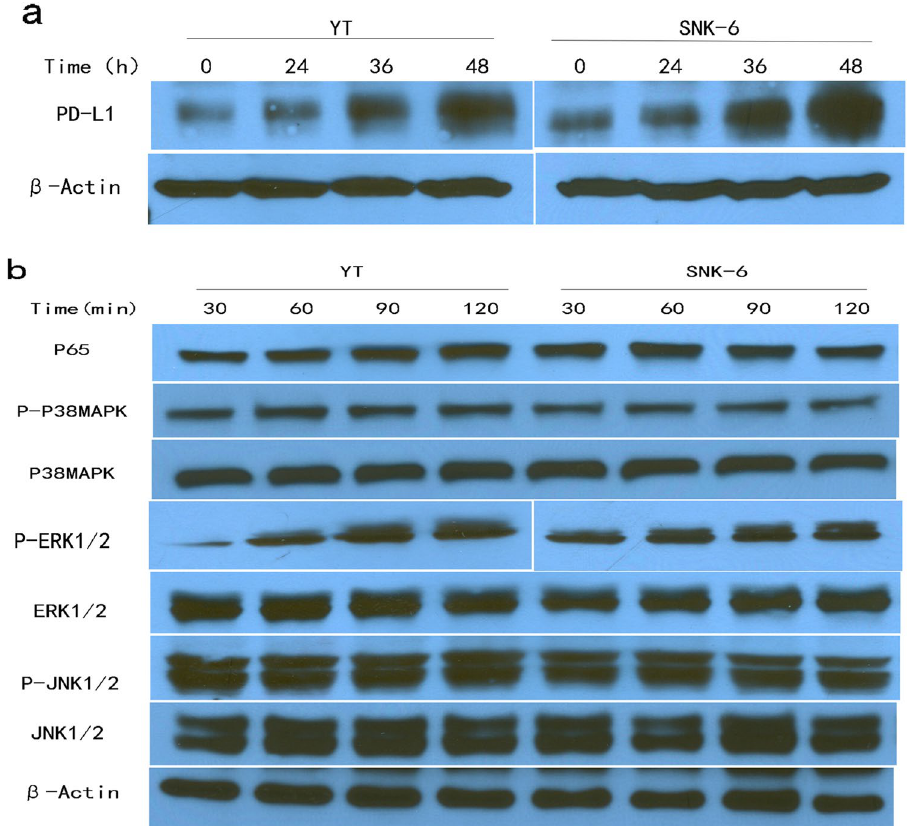
Figure 5. S100A9 upregulated PD-L1 expression and activated ERK1/2 signaling pathway Western blotting were performed to explore the effect of S100A9 on NKTCL cell lines. The blots were cut prior to hybridisation with antibodies during blotting. ( a ) NKTCL cells were exposure to S100A9 treatment for 24 h, 36 h and 48 h. PD-L1 expression on NKTCL cells were upregulated upon treatment with S100A9 protein. ( b ) Treatment with S100A9 activated ERK1/2 signaling pathway in NKTCL cells, while JNK1/2, p38 MAPK signaling were not changed.